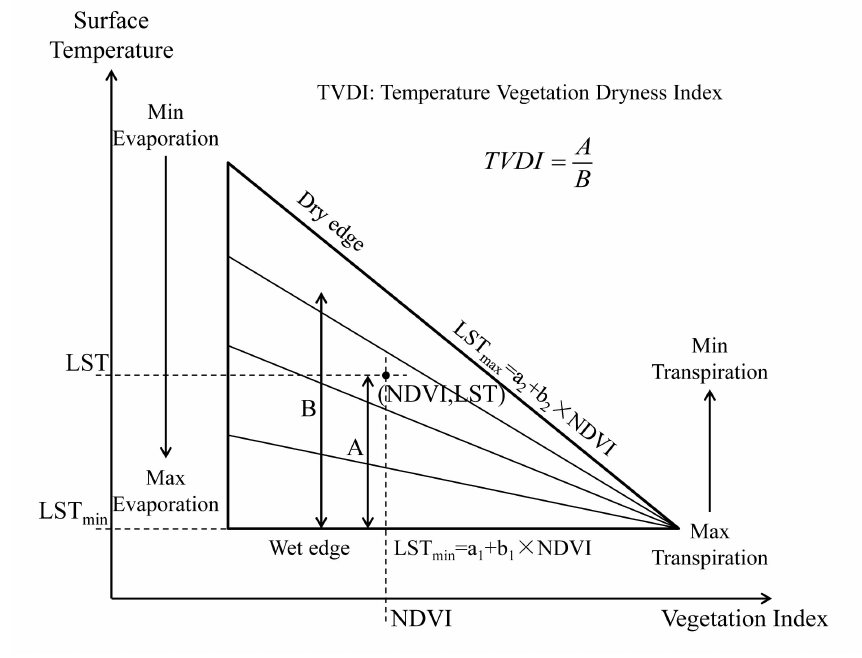
Figure 2. Definition of the TVDI